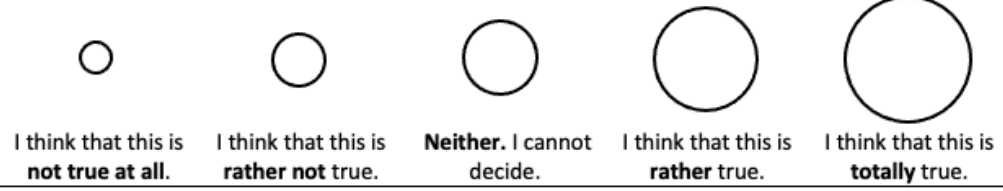
Figure A4. Questionnaire for device usability assessment (page 2).